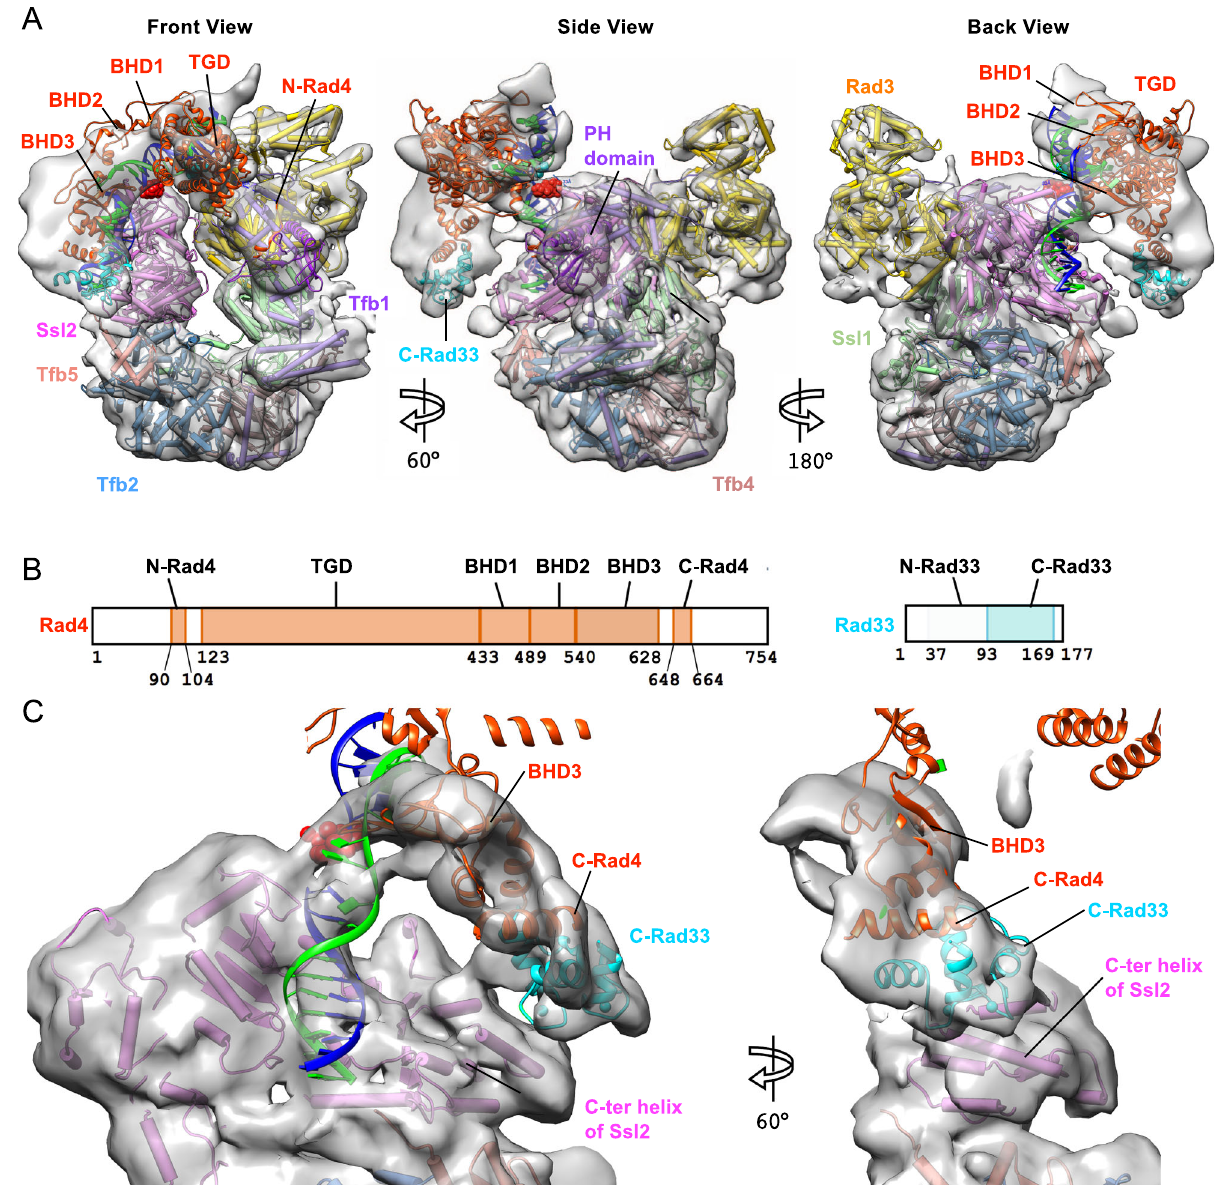
Fig. 4 Structure of TFIIH/Rad4 – Rad23 – Rad33/DNA complex. A Composite cryo-EM map of Map 2 and Map 3 of TFIIH with Rad4 – Rad23, seen in front (left), side (middle), and back (right) views. The crystal structure of Rad4-DNA complex (PDB:6CFI) was fi tted into the density as a rigid body, with the lesion (6 – 4PP) in red sphere. Rad23 did not show corresponding density. B Schematic representation of domains of Rad4 and Rad33. Domains included in the model are colored. C 7.9 Å map (Map 3) re fi ned by masking out TGD and BHD1-2. A homology model of Rad33 bound to C-Rad4 (PDB:2GGM) (cyan and orange red) was docked into a corresponding density, guided by cross-links of high con fi dence between C-Rad4 and the C-terminal region of Ssl2. The N-terminal half of Rad33 was not clearly seen. Seen in the back